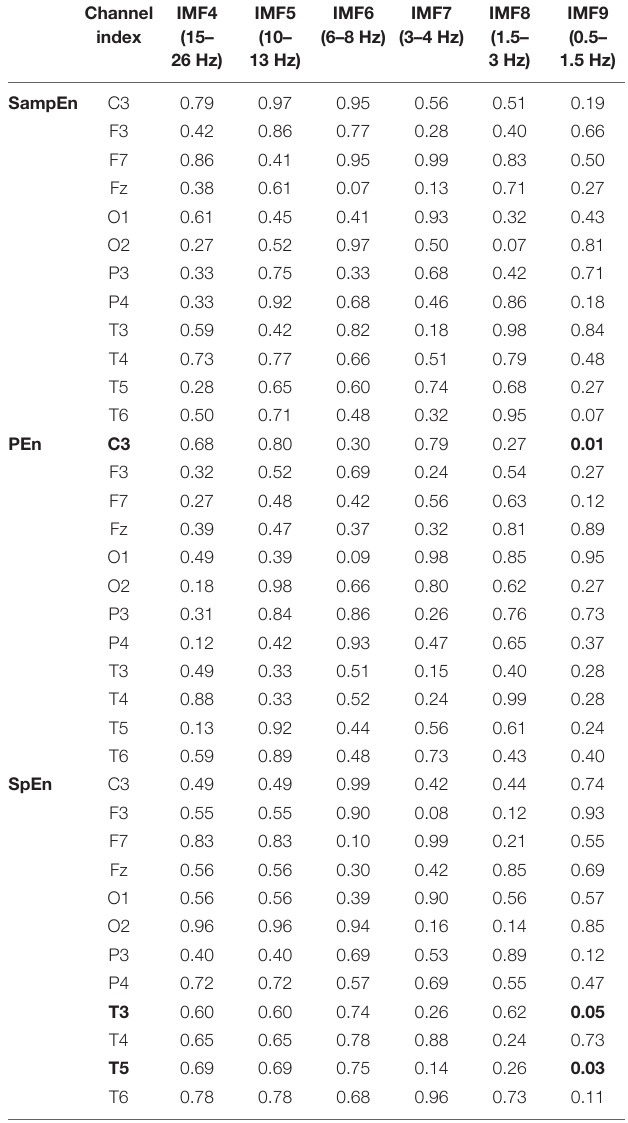
TABLE 5 | P -values of the correlation analysis of the complexity features. Channel